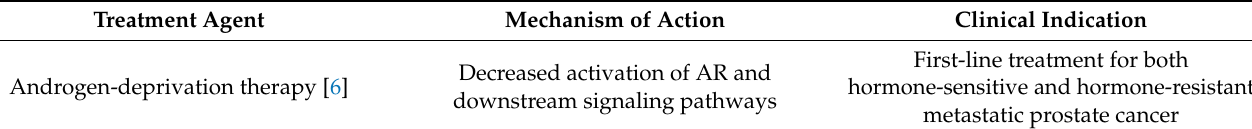
Table 1. Therapeutic agents for metastatic prostate cancer. (References in